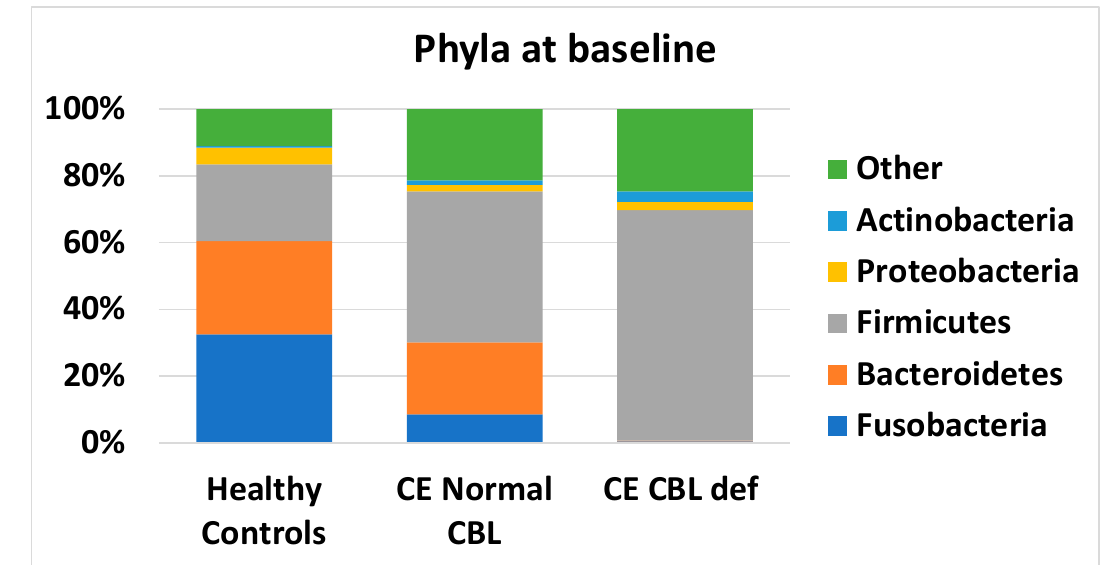
Figure 3. Median abundance of main phyla at baseline in healthy controls, in CE dogs with cobalamin deficiency, and in CE dogs with normocobalaminemia. Values are expressed in percentages of total sequences.